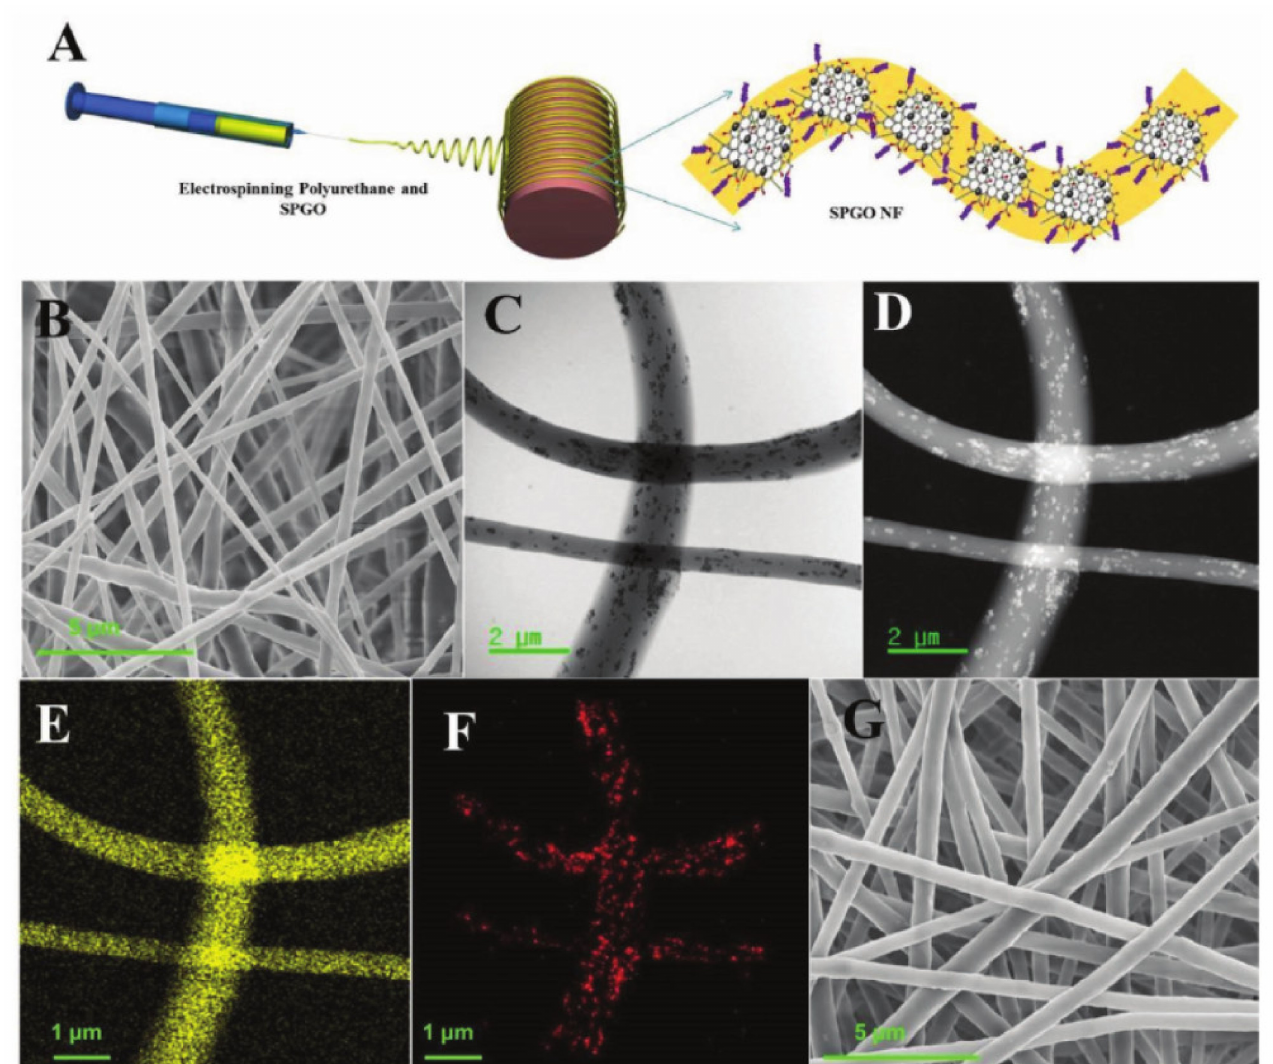
Figure 5. ( A ) Fabrication of the superparamagnetic graphene oxide (SPGO) NF. ( B ) FESEM image of the SPGO NF. ( C , D ) Brightfield and darkfield TEM images of the SPGO NF showing the uniform distribution of SPGO inside the NF matrix. ( E ) Element mappings of carbon. ( F ) Element mappings of iron. ( G ) FESEM image of the SPGO DOX NF. Reprinted with permission from ref. [65]. Copyright 2018 John Wiley and